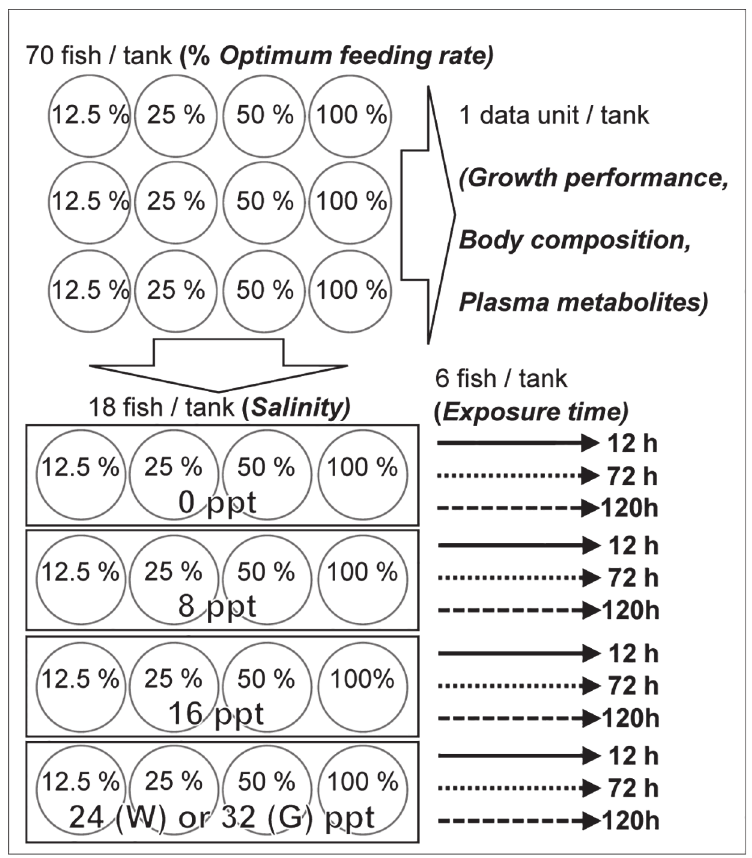
Fig 1. Experimental design. First phase (top): Four levels of one treatment, feeding rate (12.5, 25, 50, 100%). Second phase (bottom): Four levels of the treatment salinity (0, 8, 16, 24/32 ppt), and three levels of the exposure time to salinity levels (12, 72, 120 h). The experimental design was the same for the two species, except that maximum salinity was different for white (W) and green (G) sturgeon.